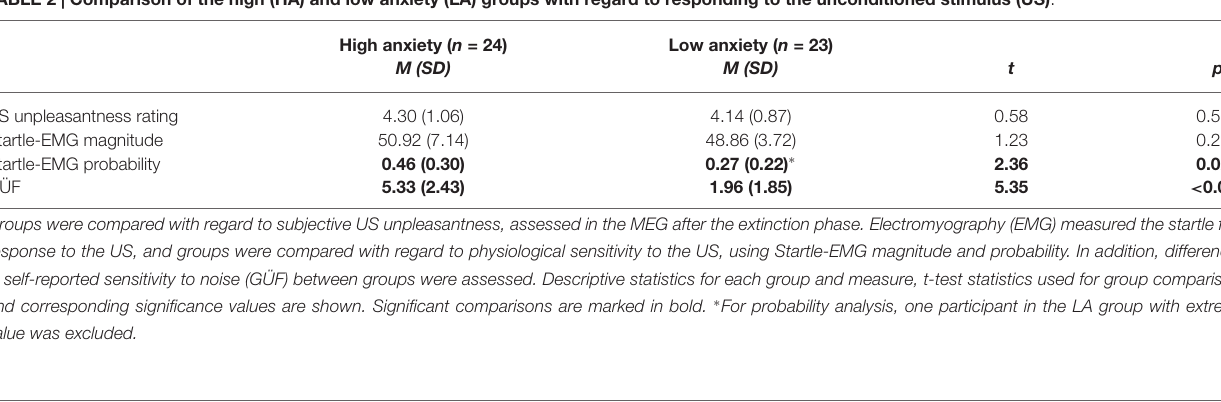
TABLE 1 | Comparison between the high (HA) and low anxiety (LA) groups . High anxiety ( n = 24)